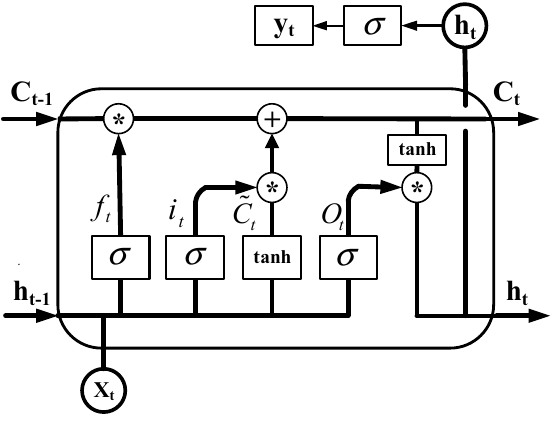
Figure 1. The structure of the LSTM network.